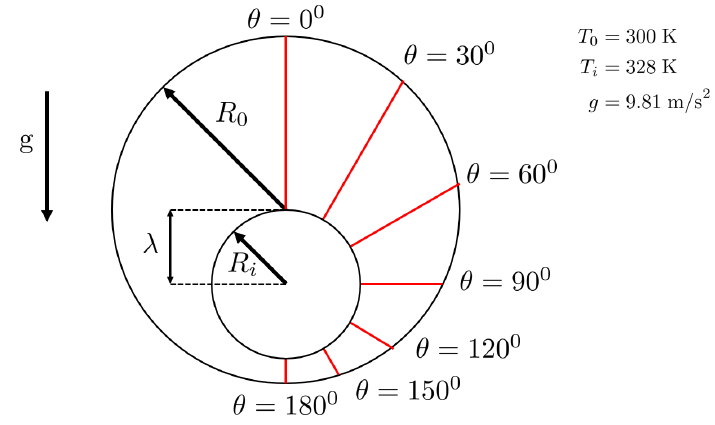
Figure 1. Problem description.